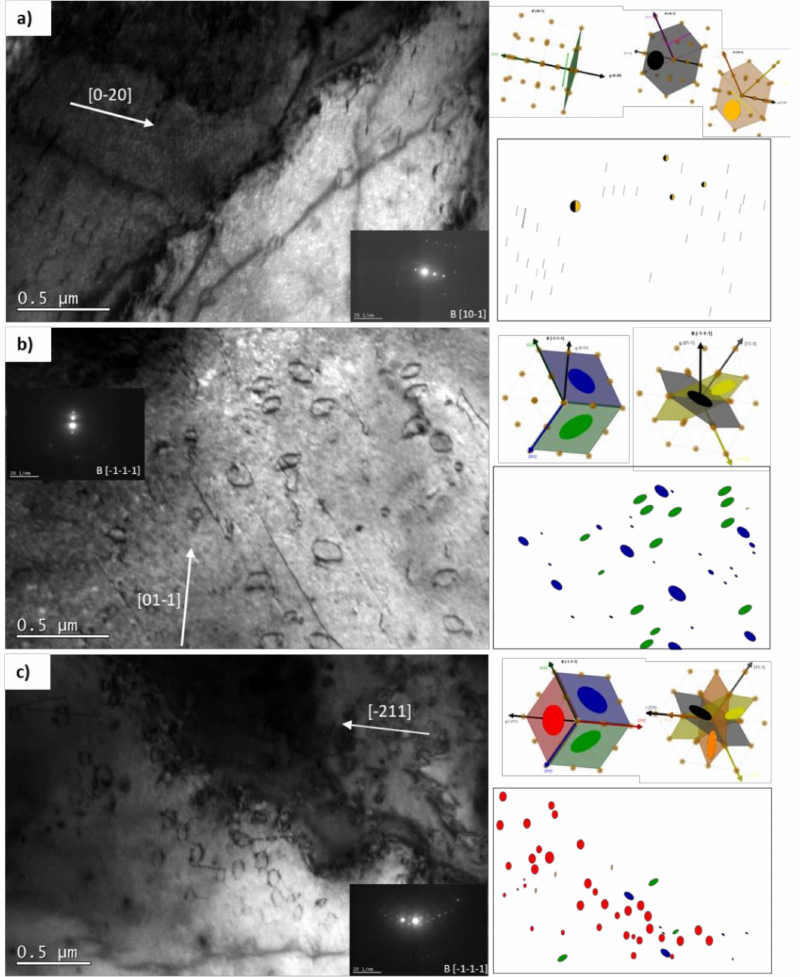
Figure 20. TEM micrographs of pure EFDA iron irradiated with Fe ions at 20 MeV at 300 ◦ C up to 8.5 × 10 15 ions/cm 2 under ( a ) [101] with g [020]; ( b ) [111] with g [011]; and ( c ) [111] with g [211], showing the results for every